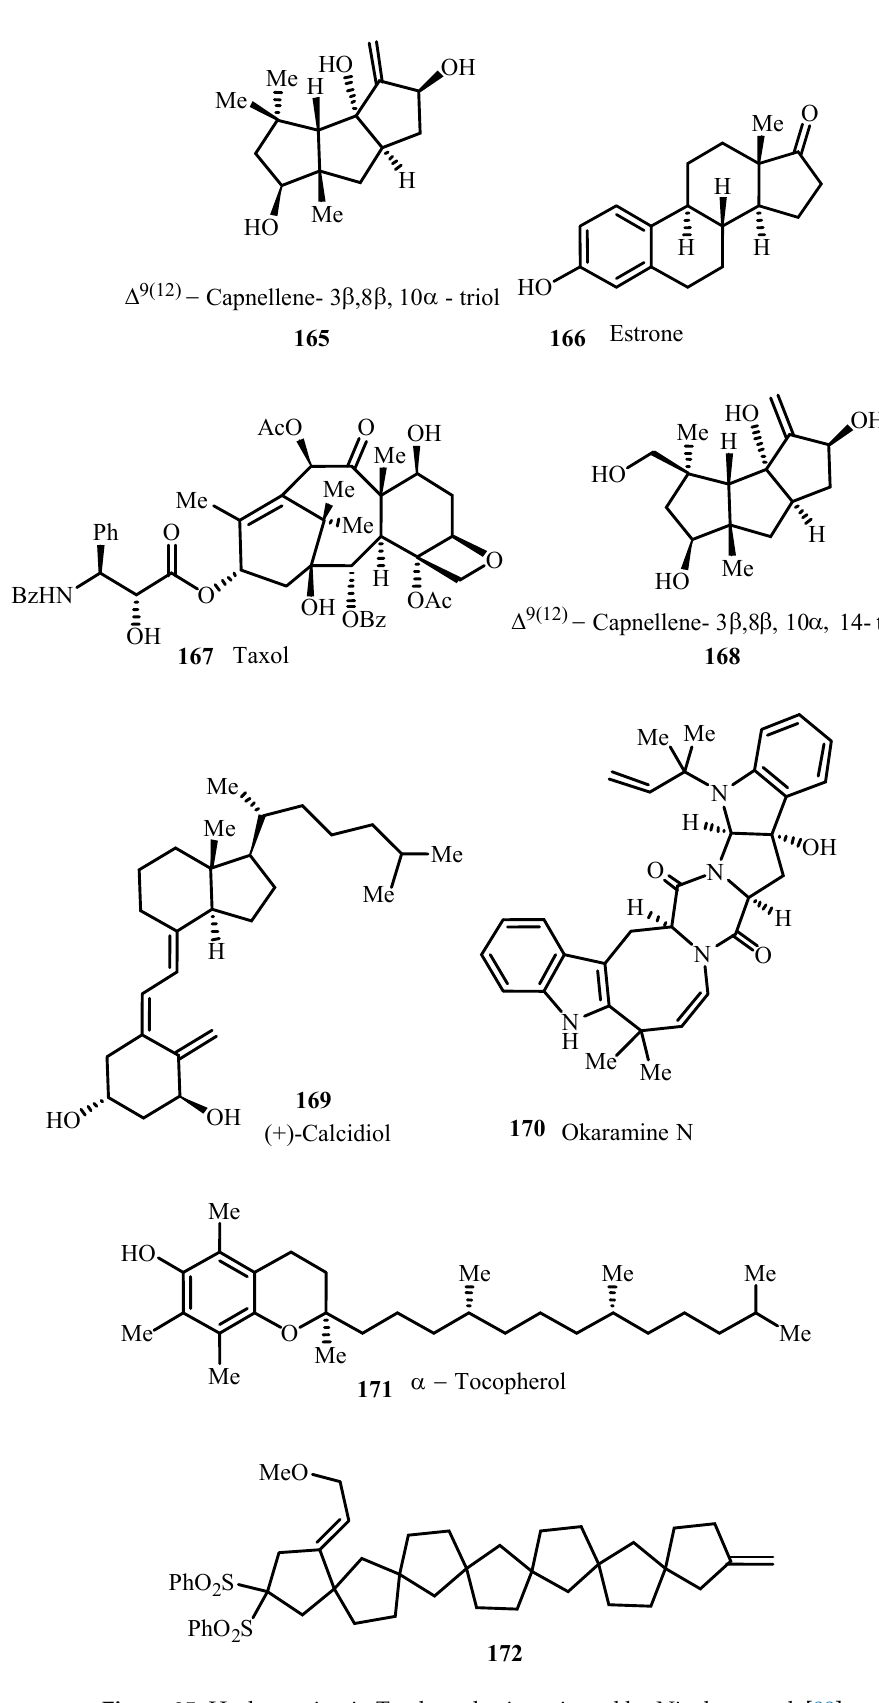
Figure 25. Heck reaction in Total synthesis reviewed by Nicolaou et al.